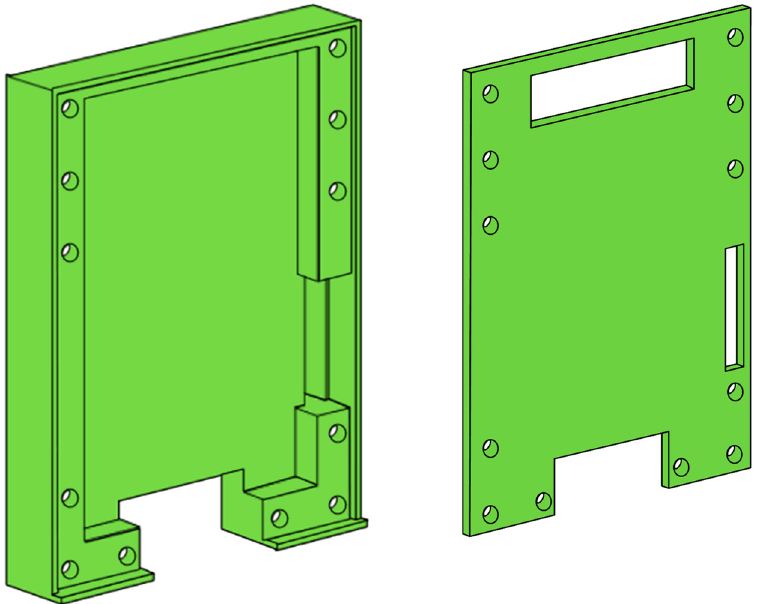
Figure 5. Metal enclosure.